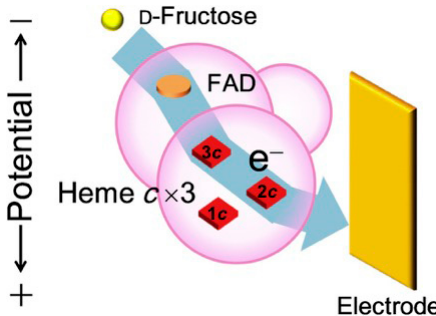
Figure 4. Proposed ET pathway from D-fructose to the electrode surface in the DET of FDH. The ET route involves FAD, heme 3 c , heme 2 c , but not heme 1 c . Reproduced with permission from [30]. Copyright 2019, Elsevier.